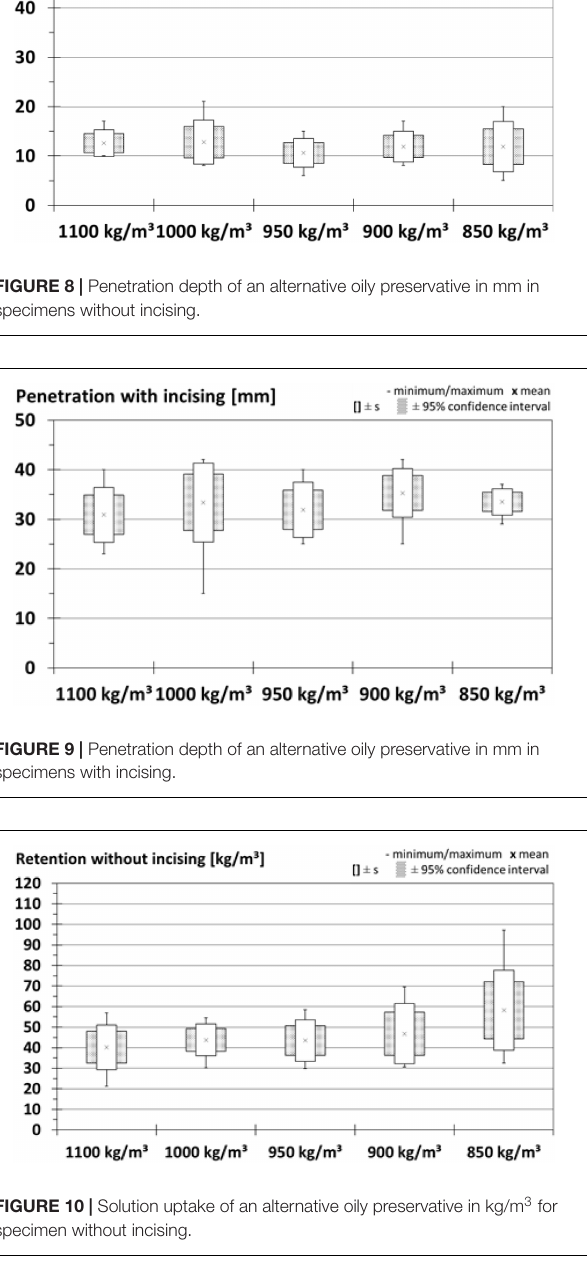
While the mean retention at all gross weights for specimens without incision was 46.5 kg/m 3 , it was 72.0 kg/m 3 for specimens with incision ( Figures 10 , 11 ).